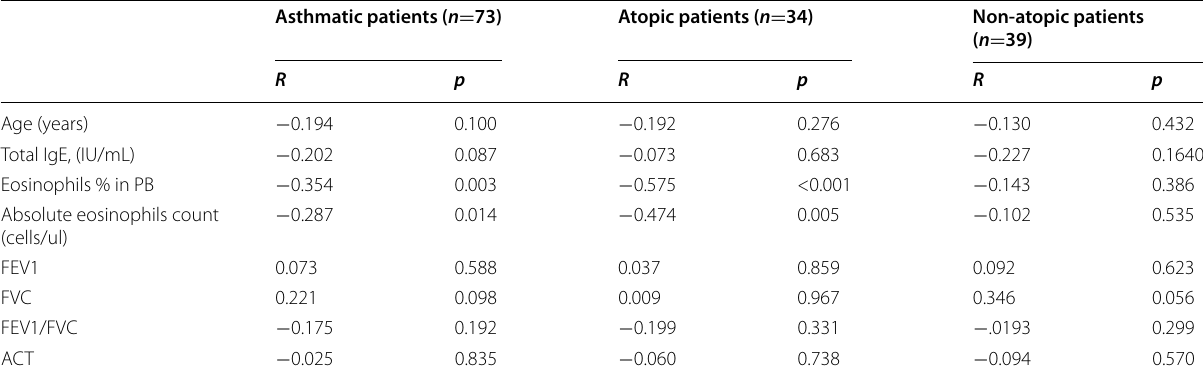
Table 3 Correlation of IL-38 serum levels with different demographic, clinical, and laboratory outcomes of the asthmatic groups